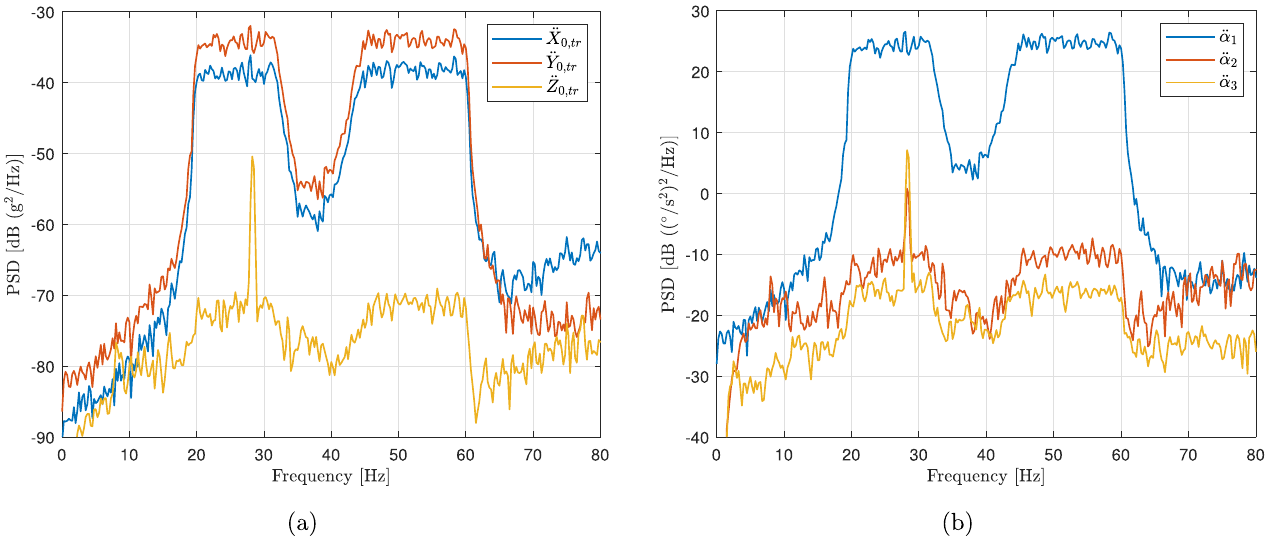
Fig. 7. PSD in acceleration of the 6 DOFs of the rotor base for the random excitation: (a) pure translational DOFs and (b) angular